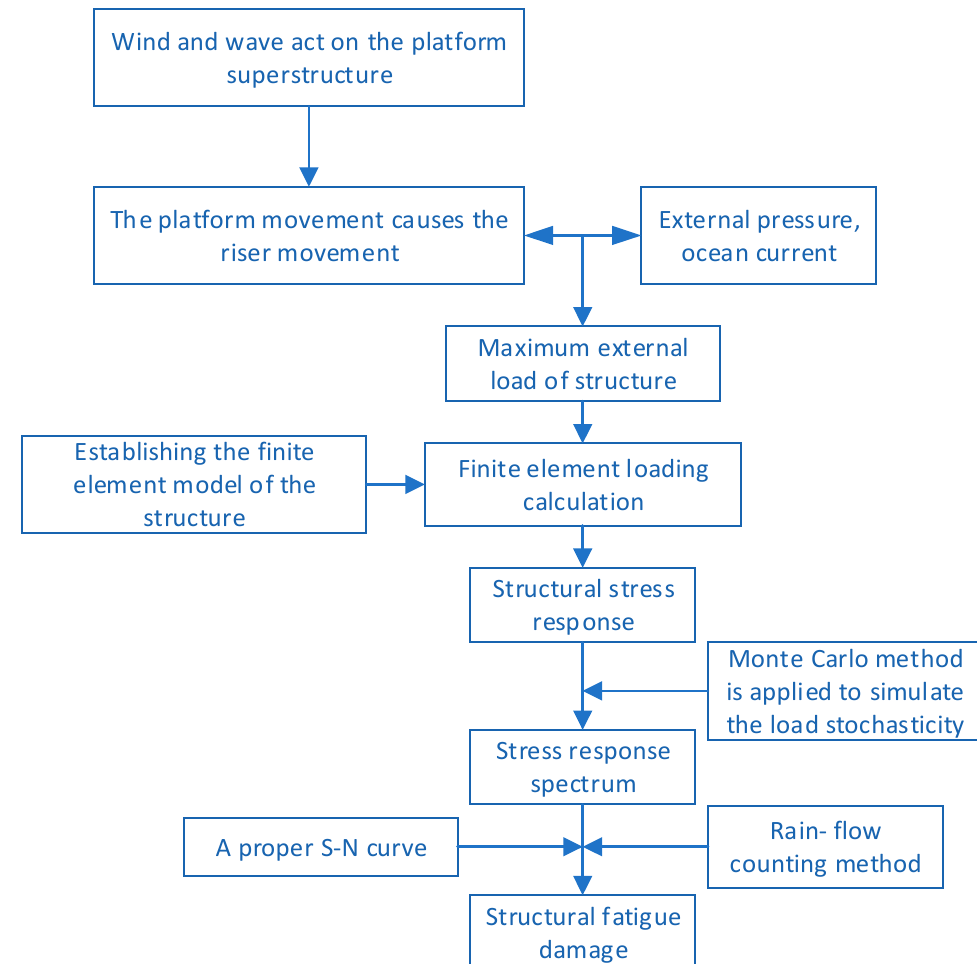
Figure 2. The fatigue spectrum analysis process. Risers are subjected not only to external loading but also to internal loading. Much research has been done on the effect of internal pressure in multilayered risers and pipe- lines [18–22]. The internal pressure usually does not have a significant effect on fatigue during stable oil and gas collection. Therefore, it is assumed in this paper that the influ- ence of internal loading is ignored. The riser selected in this paper has a total of 9 layers. From the interior to exterior, they are the skeleton layer, internal sheath layer, compressive armor layer, internal anti-friction layer, internal tensile armor layer, external anti-friction layer, external tensile armor layer, four-fold anti-friction layer, and external sheath layer. Among them, the four-fold anti-friction layer is a four-fold structure, which is treated as one layer in the analysis. The solid structure of the riser is shown in Figure 3 .